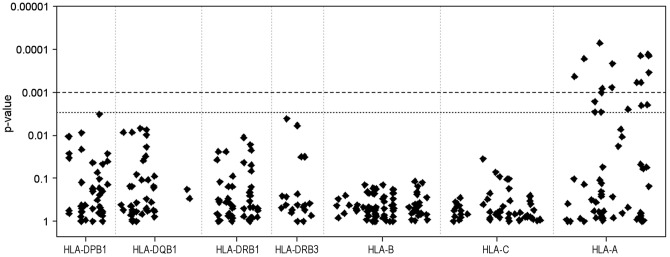
Genetic association of individual PCR-SSOP in EBV+ cHL.The p-value of each SSOP for differences in frequencies between EBV+ and EBV− cHL cases is plotted on the y-axis. Genes are ordered according to their relative positions on the short arm of chromosome 6 (6p-telomere to 6p-centromere). Strong associations with EBV status were present only for part of the PCR-SSOPs within the HLA-A gene.